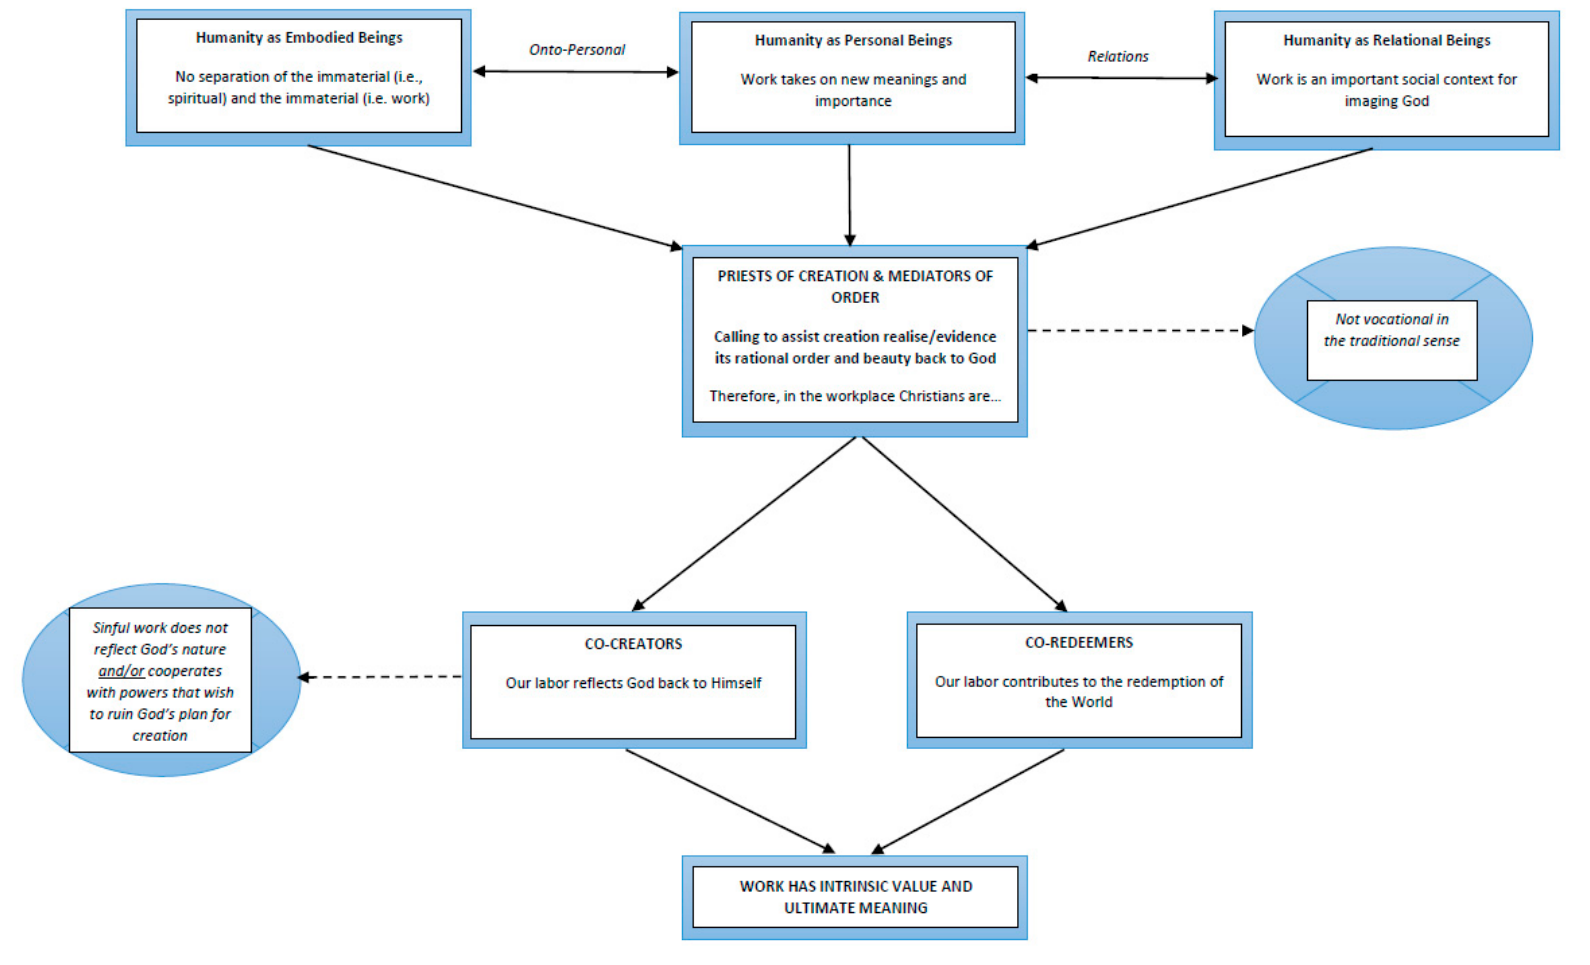
Figure 1. Humanity at Work (Adapted from McGhee and Habets 2018, p. 85).